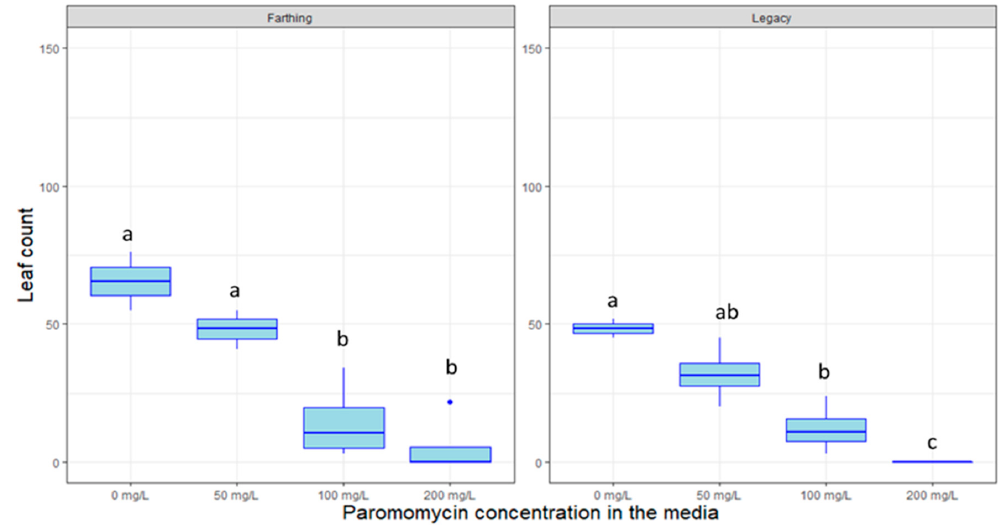
Figure 7. Box plot distribution of the effect of the selectable antibiotic markers paromomycin on leaf proliferation of two blueberry genotypes grown in tissue culture, “Farthing” ( left panels) and “Legacy” ( right panels). Letters above boxplots indicate multiple comparison test. Treatments with the same letters are not statistically different at alpha = 0.05.